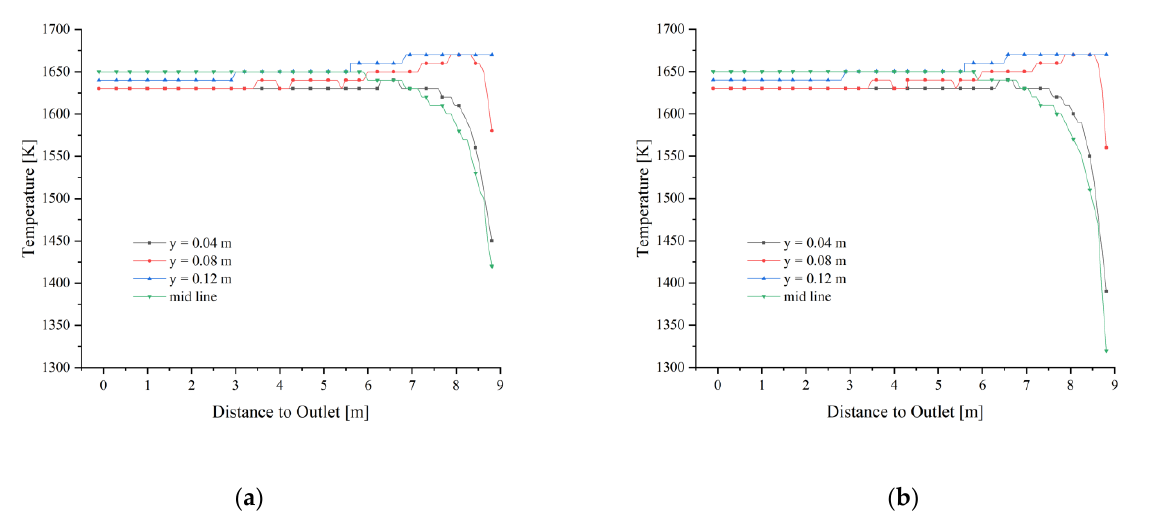
Figure 8. Solid temperature field at 40 mm and 80 mm ( a ) Solid surface temperature of 40 mm; ( b ) Solid surface temperature of 80 mm.